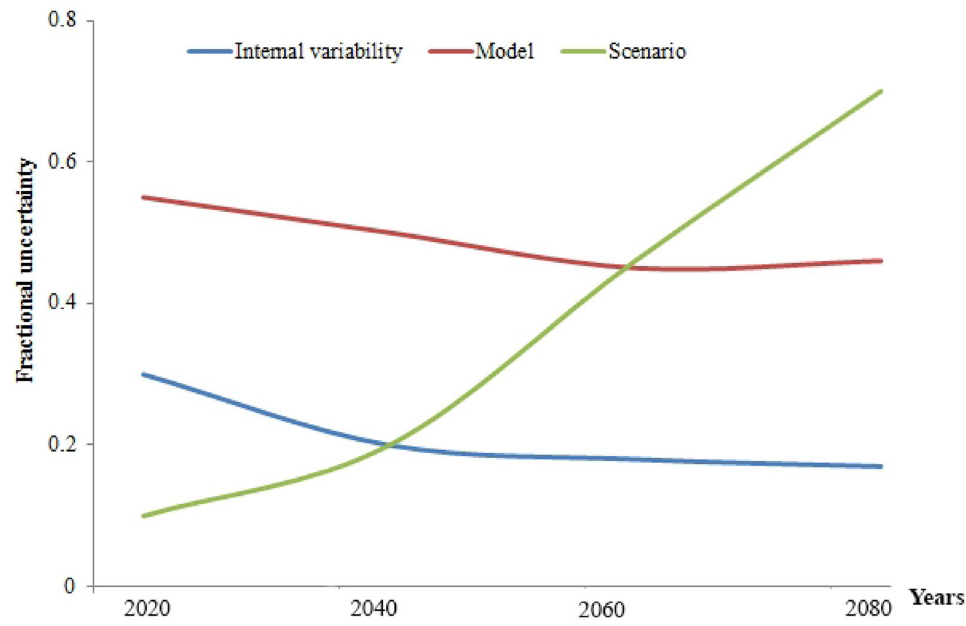
Fig. 9 Fractional uncertainty with the 90% confidence level divided by the average estimation over the study area. Different uncertainties were computed for internal variability, model and scenario